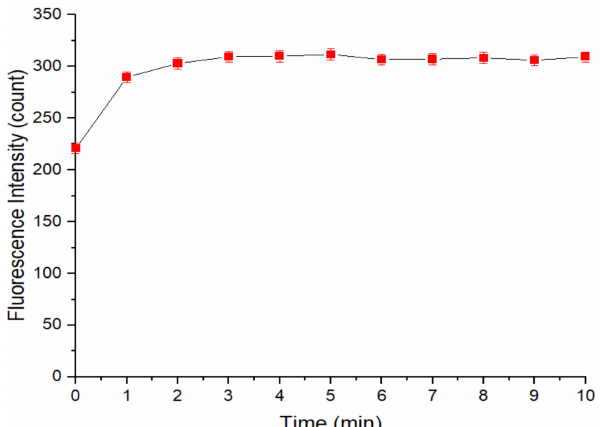
Figure 8. Relationship between the fluorescence intensity of the restored QD solution and the time after addition of the cadmium standard solution. Concentration of Tris-HCl bu ff er solution: 10 mmol / L. pH of Tris-HCl bu ff er solution: 8.5. Concentration of added QD solution: 5 µ mol / L. Concentration of APDC solution: 100 µ mol / L. Concentration of cadmium standard solution: 1 g / L. Addition order: Tris-HCl bu ff er solution (2 mL) → QD solution (0.4 mL) → APDC solution (0.52 mL) → cadmium